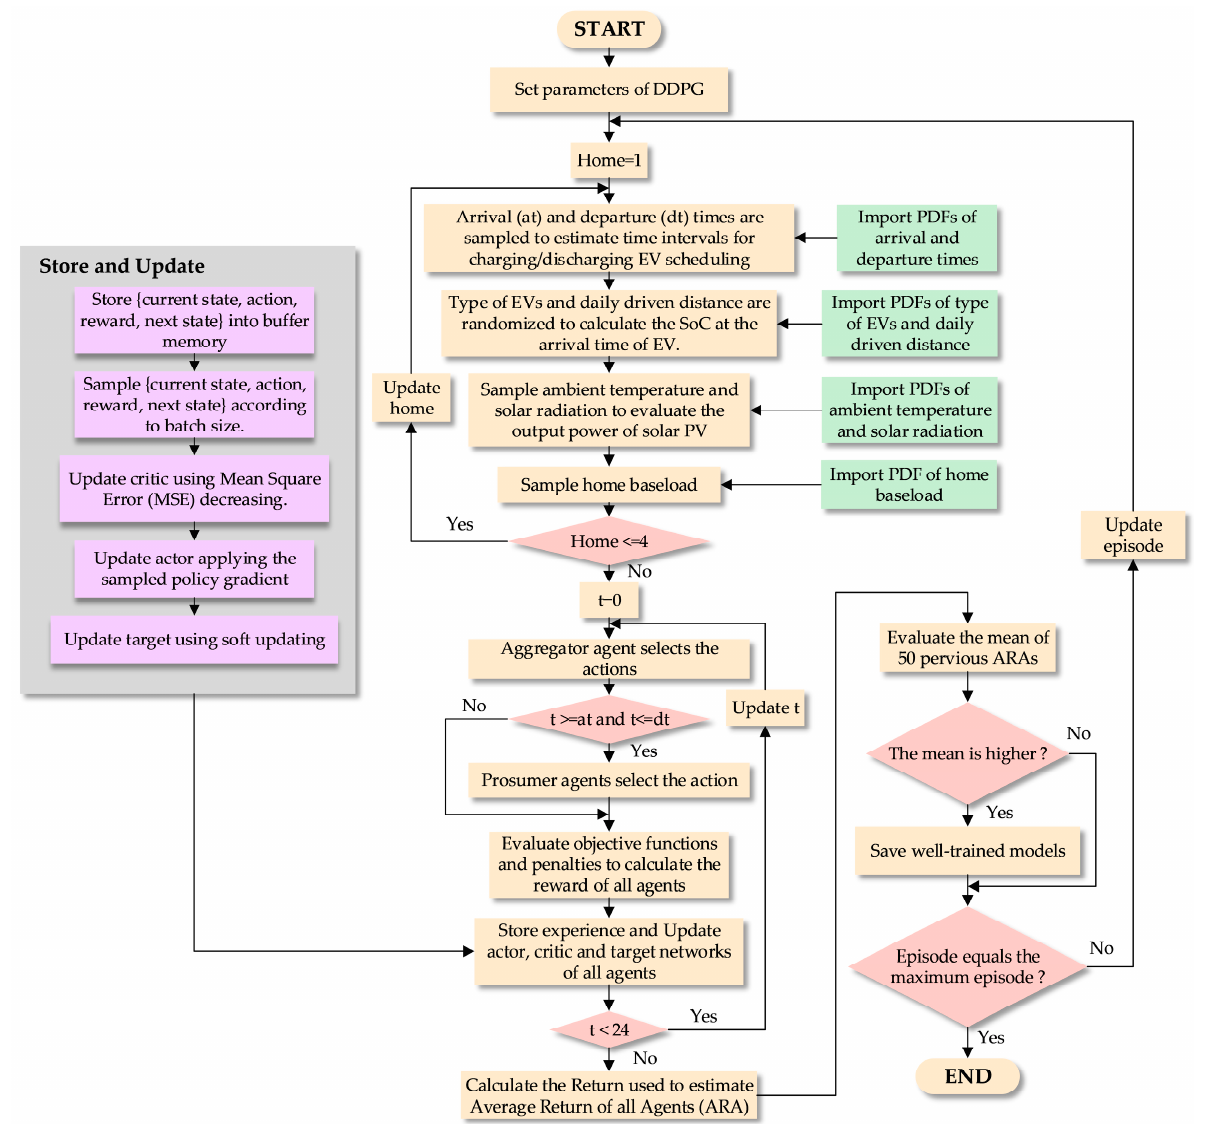
Figure 3. The training procedure for multi ‐ agent optimization.